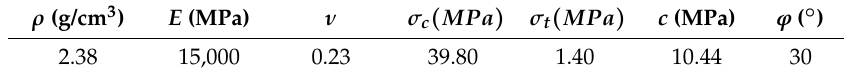
Table 1. Specimen’s parameters.